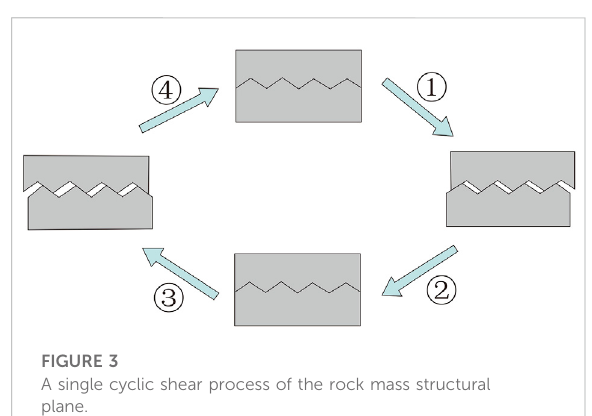
FIGURE 3 A single cyclic shear process of the rock mass structural